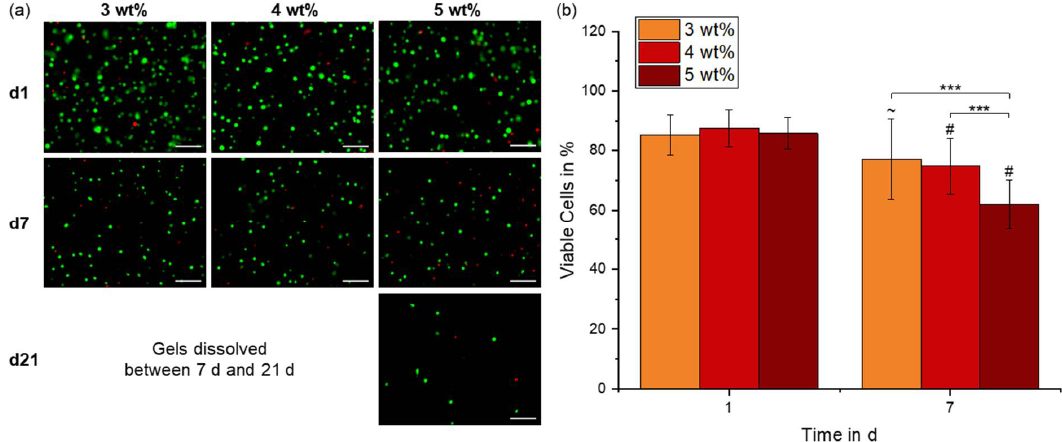
Figure 6. Cell viability in blend hydrogels: ( a ) Cell viability of in vitro cultured hMSCs in 3, 4, and 5 wt% blend hydrogels (DO 53.3%) after days 1, 7, and 21 in proliferation medium, shown by live/dead staining. Viable cells were labeled green with calcein-AM and dead cells with EthD-I. Scale bars represent 100 µm; ( b ) Quantification of viable cells, after days 1 and 7 of in vitro culture in proliferation medium. Data are presented as means ± standard deviation ( n = 3 per condition and time point, counting at least eight locations for each sample). Significant differences between groups at day 7 are marked with *** ( p < 0.001), labels above bars of groups at day 7 show significant differences as compared with day 1. “~” p < 0.01 and “ # ” p < 0.001.